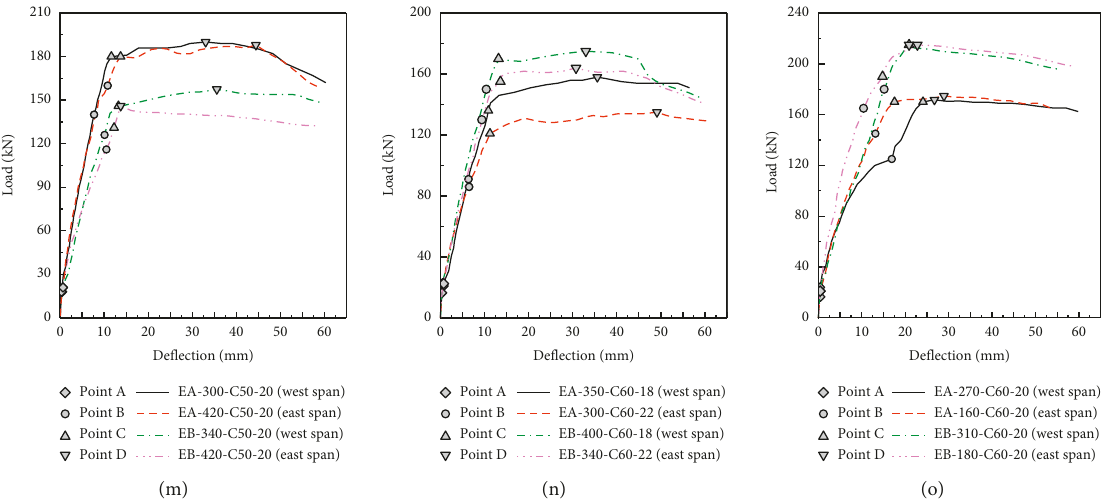
Figure 6: Load versus displacement curve. (a) IA/B-C40-18. (b) IA/B-C40-20. (c) IA/B-C40-22. (d) IA/B-C50-18. (e) IA/B-C50-20. (f) IA/ B-C50-22. (g) IA/B-C60-18. (h) IA/B-C60-20. (i) IA/B-C60-22. (j) EA/B-C40-18/22. (k) EA/B-C40-20. (l) EA/B-C50-18/22. (m) EA/B-C50-